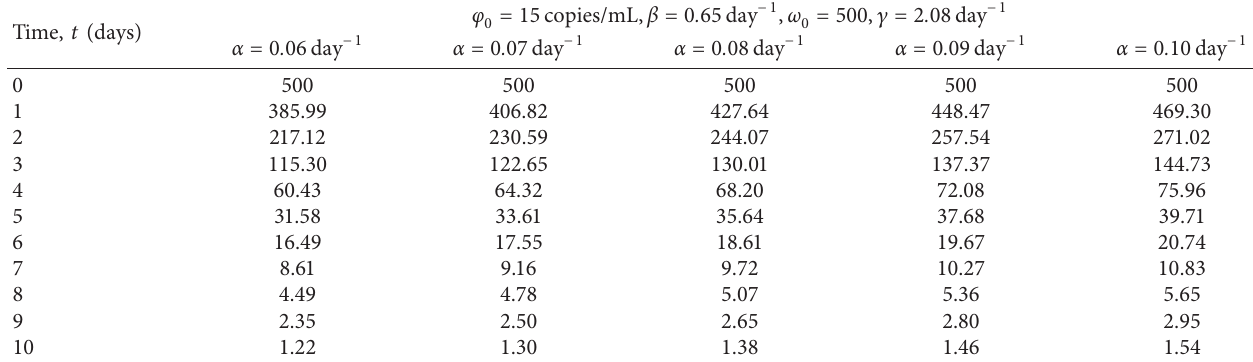
� 15copies/mL , β � 0 . 65 day − 1 , ω 0